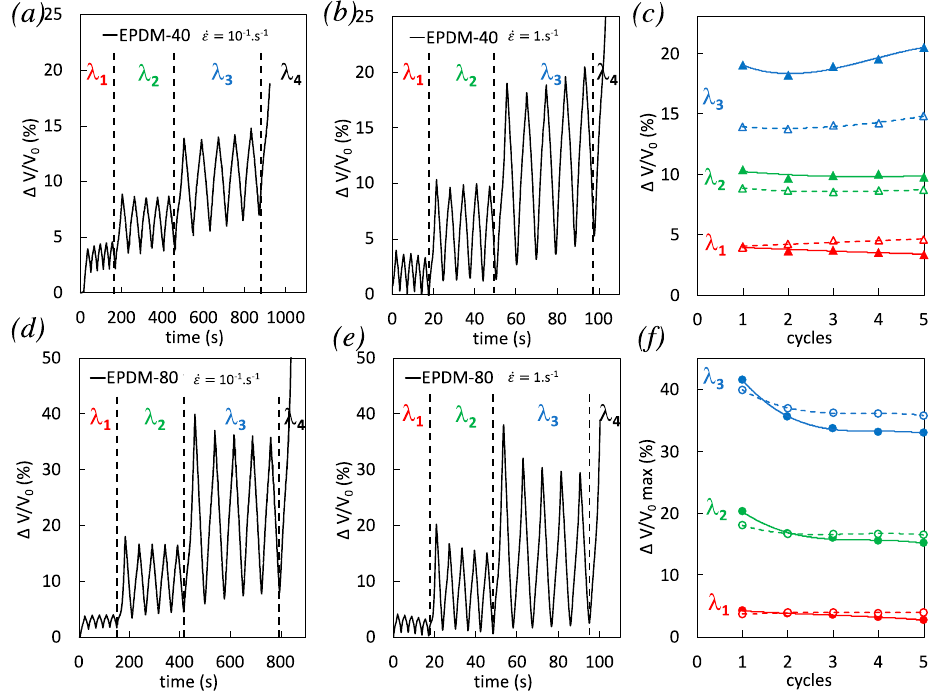
Figure 8. ( a – b ) Volumetric strain at the strain rates 10 − 1 s − 1 and 1 s − 1 for EPDM-40. ( c ) Corresponding maximum volumetric strain reached during multiple cyclic loadings performed at three different stretching ratios λ 1 = 2 (in red), λ 2 = 2.9 (in green), and λ 3 = 3.7 (in blue), and for the strain rates 10 − 1 s − 1 (unfilled symbols) and 1 s − 1 (filled symbols). ( d – e ) Volumetric strain at the strain rates 10 − 1 s − 1 and 1 s − 1 for EPDM-80. ( f ) Corresponding maximum volumetric strain reached during multiple cyclic loadings performed at three different stretching ratios λ 1 = 2 (in red), λ 2 = 2.9 (in green), and λ 3 = 3.7 (in blue), and for the strain rates 10 − 1 s − 1 (unfilled symbols) and 1 s − 1 (filled symbols).